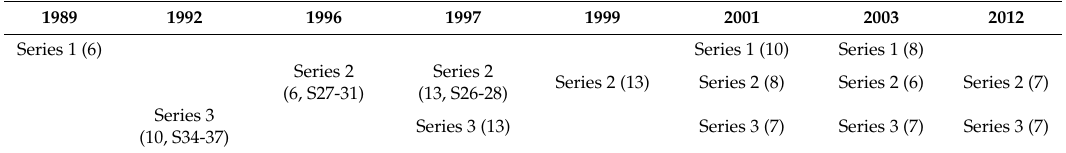
Table 1. Downstream shoulder: Time periods and control stations with uplift movements. The numbers in brackets show the max uplift movement in mm that has taken place between the measurement epoch on the year shown in the table and the previous year. If uplift is observed for only specific stations along a series, these are also shown.